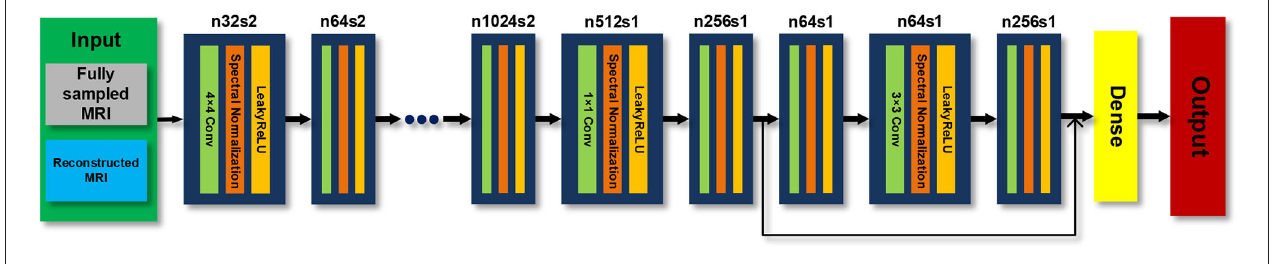
FIGURE 3 | Discriminator model.